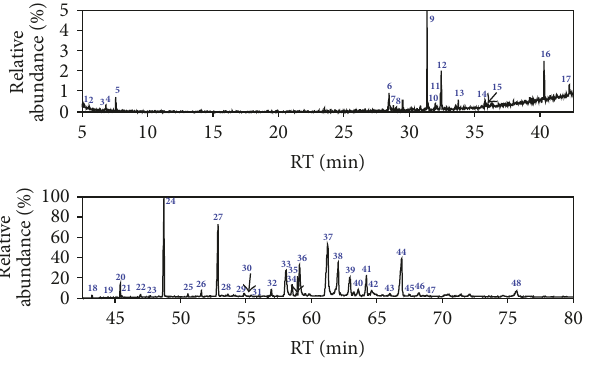
Figure 2: TICs of EF PE from WS. Figure 3: TICs of EF CS 2 from WS.